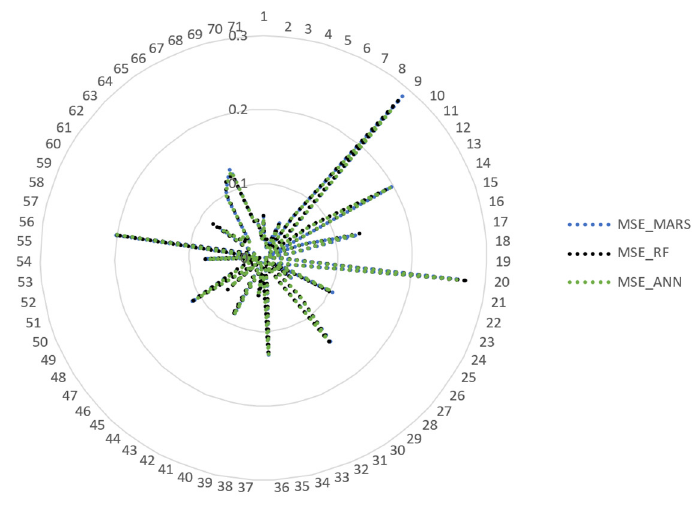
Figure 5. Radar chart involving MSE (in kWh 2 ) for different Consumer IDs.